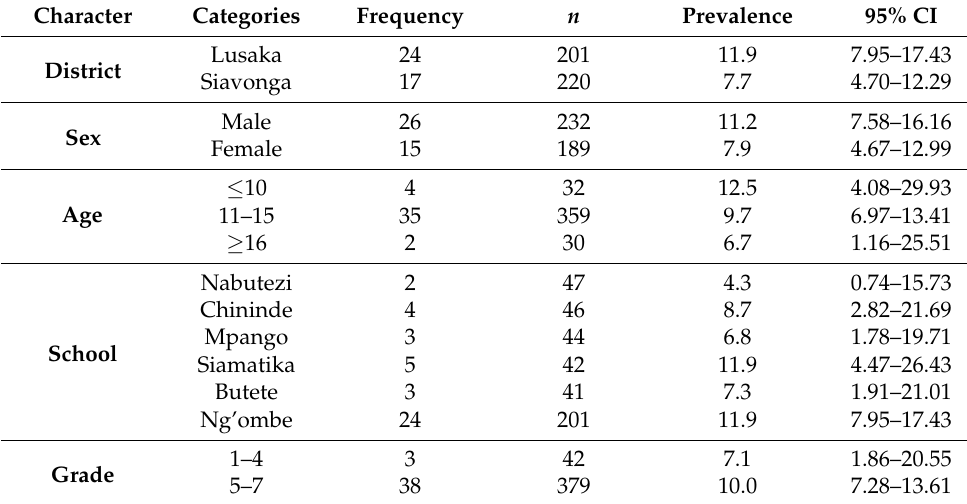
Table 3. District, Age, School, Grade and Sex-Specific